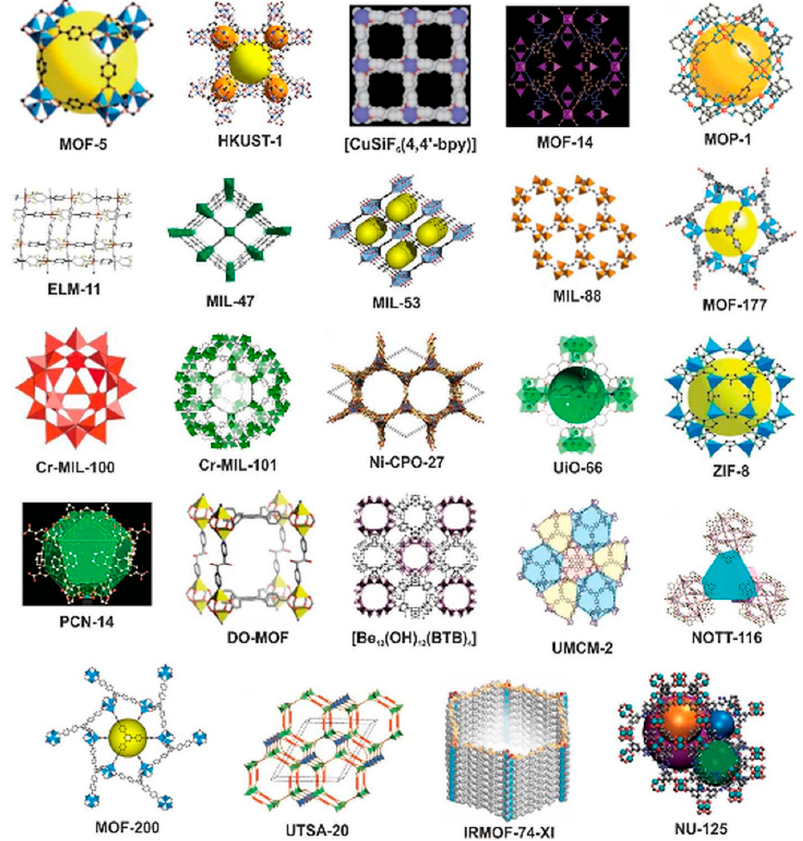
Figure 2. Examples of typical metal-organic framework (MOF) structures. Reproduced from Ref. [77] with permission from the Royal Society of Chemistry.